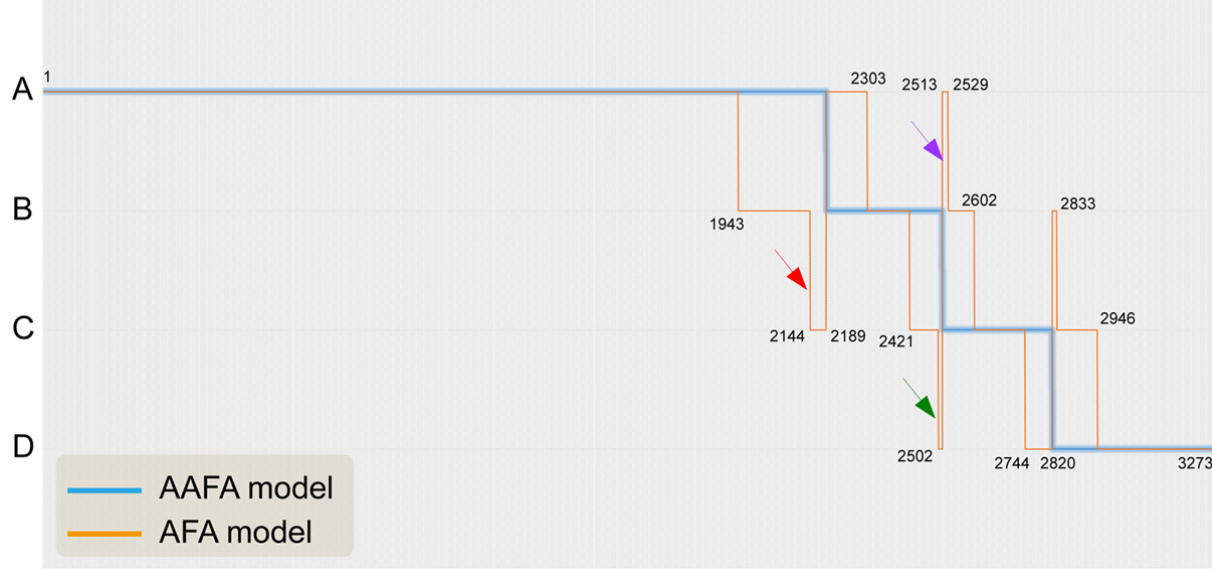
Figure 2. Specific differences between the AAFA and AFA models in A-D groups.